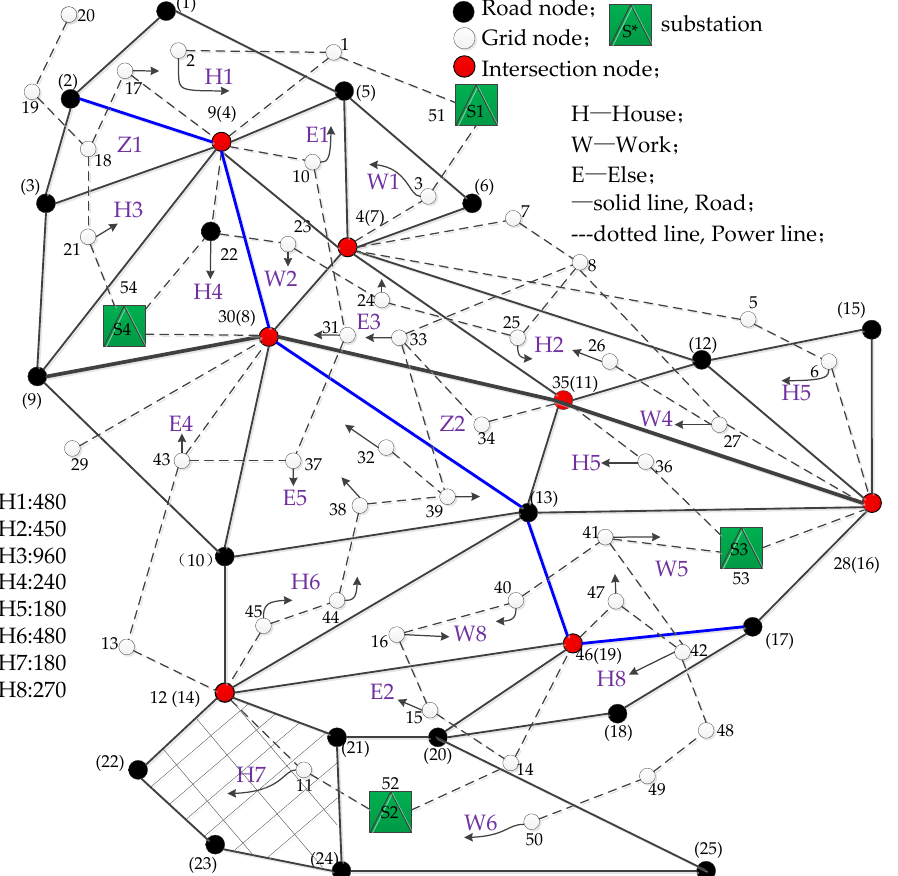
Figure 6. Topology coupled road network and distribution network.